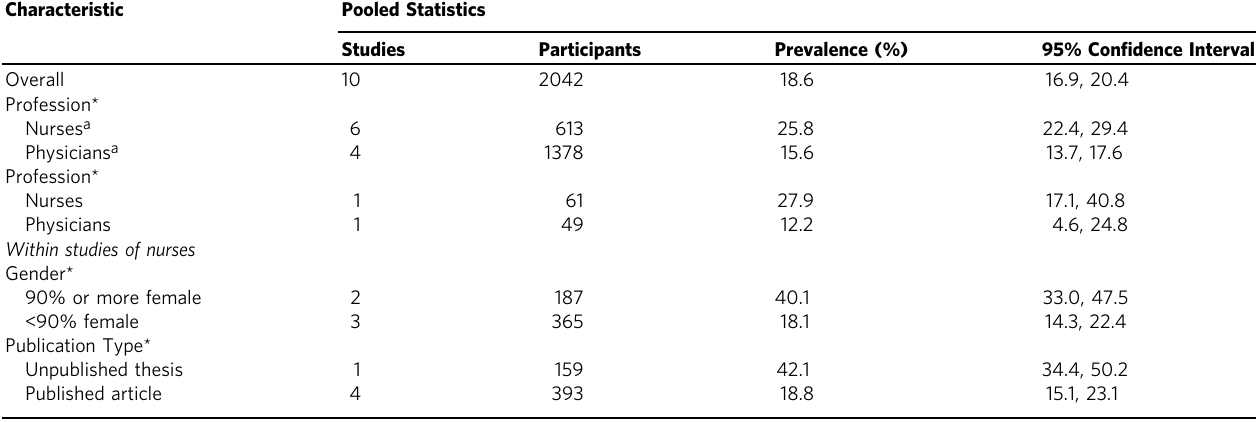
Table 2 Posttraumatic stress disorder prevalence moderated by participant and study characteristics.